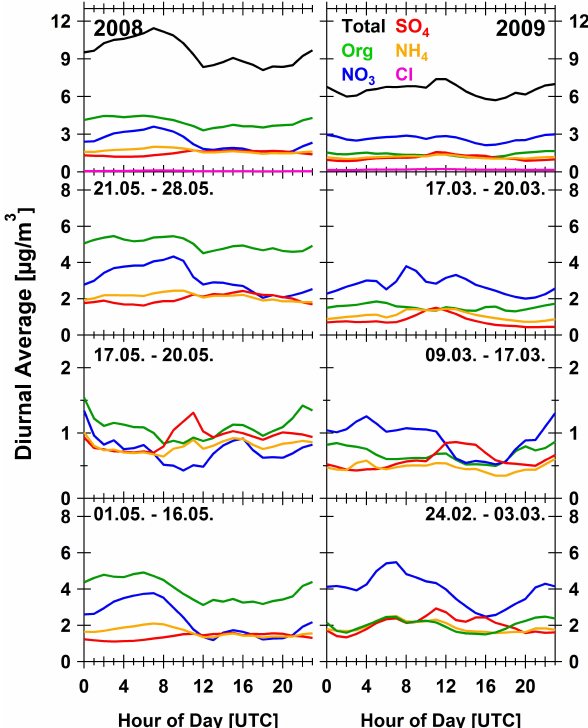
Fig. 9. Average diurnal variation of the total mass (black), organics (green), nitrate (blue), sulfate (red), ammonium (orange), and chlo- ride (purple) as campaign averages (top panels) and for each of the individual meteorological periods encountered in May 2008 (left) and March 20009